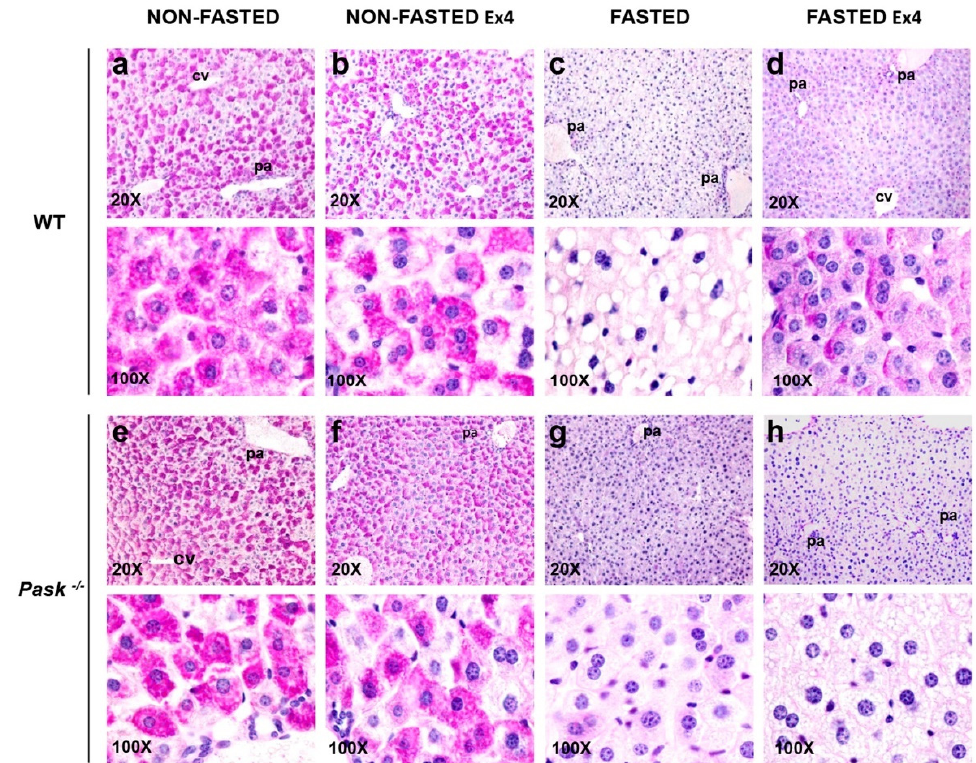
Figure 4. Exendin-4 and PASK deficiency alter glycogen accumulation in the liver. Histological sections from livers of wild-type (WT) and PASK-deficient mice ( Pask − / − ) either non-fasted (NON-FASTED) or 48-h fasted (FASTED), treated or not with exendin-4 (Ex4) for 3 h, were stained with PAS for glycogen examination. Representative micrographs of WT ( a – d ) and PASK-deficient mice ( e – h ) are shown at 20 × (upper panels) and 100 × magnification (bottom panels). Two different mice were used in each condition. pa: portal area, cv: centrilobular